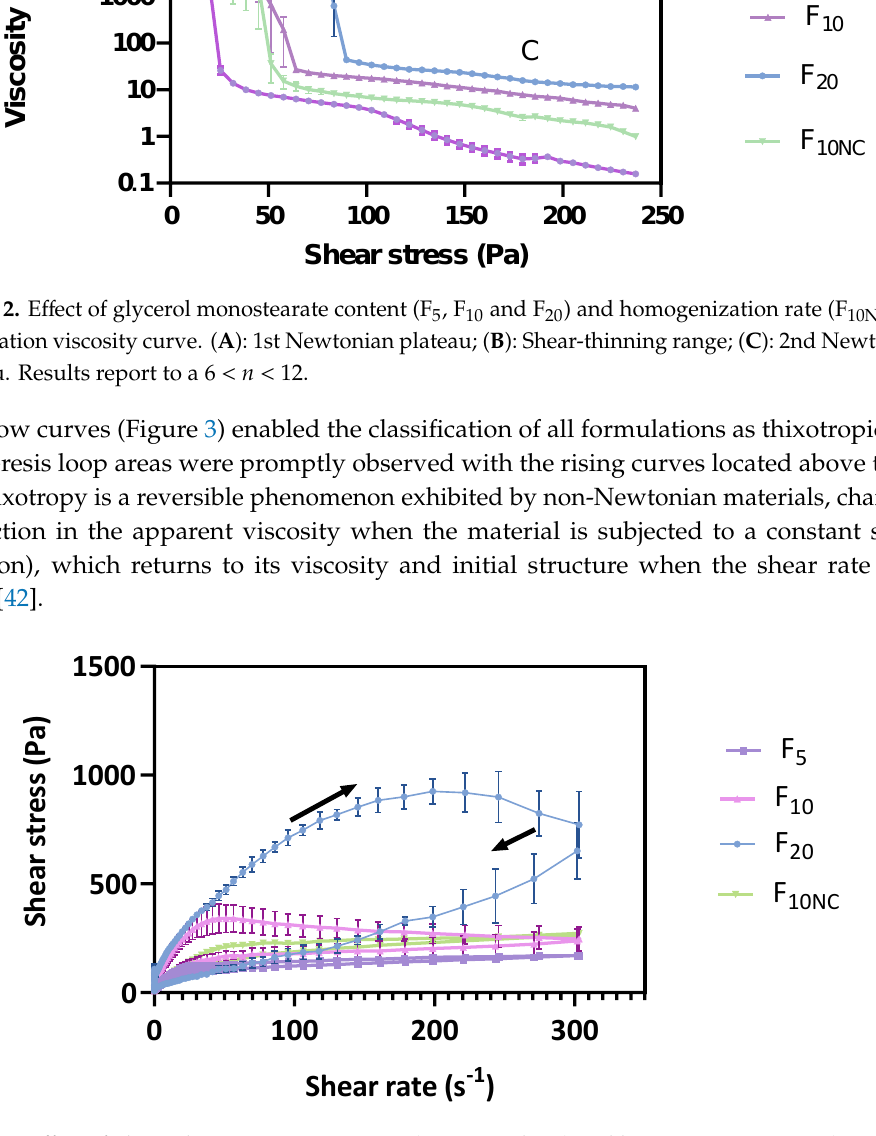
Figure 3. E ff ect of glycerol monostearate content (F 5 , F 10 and F 20 ) and homogenization rate (F 10NC ) on formulation thixotropic relative area.